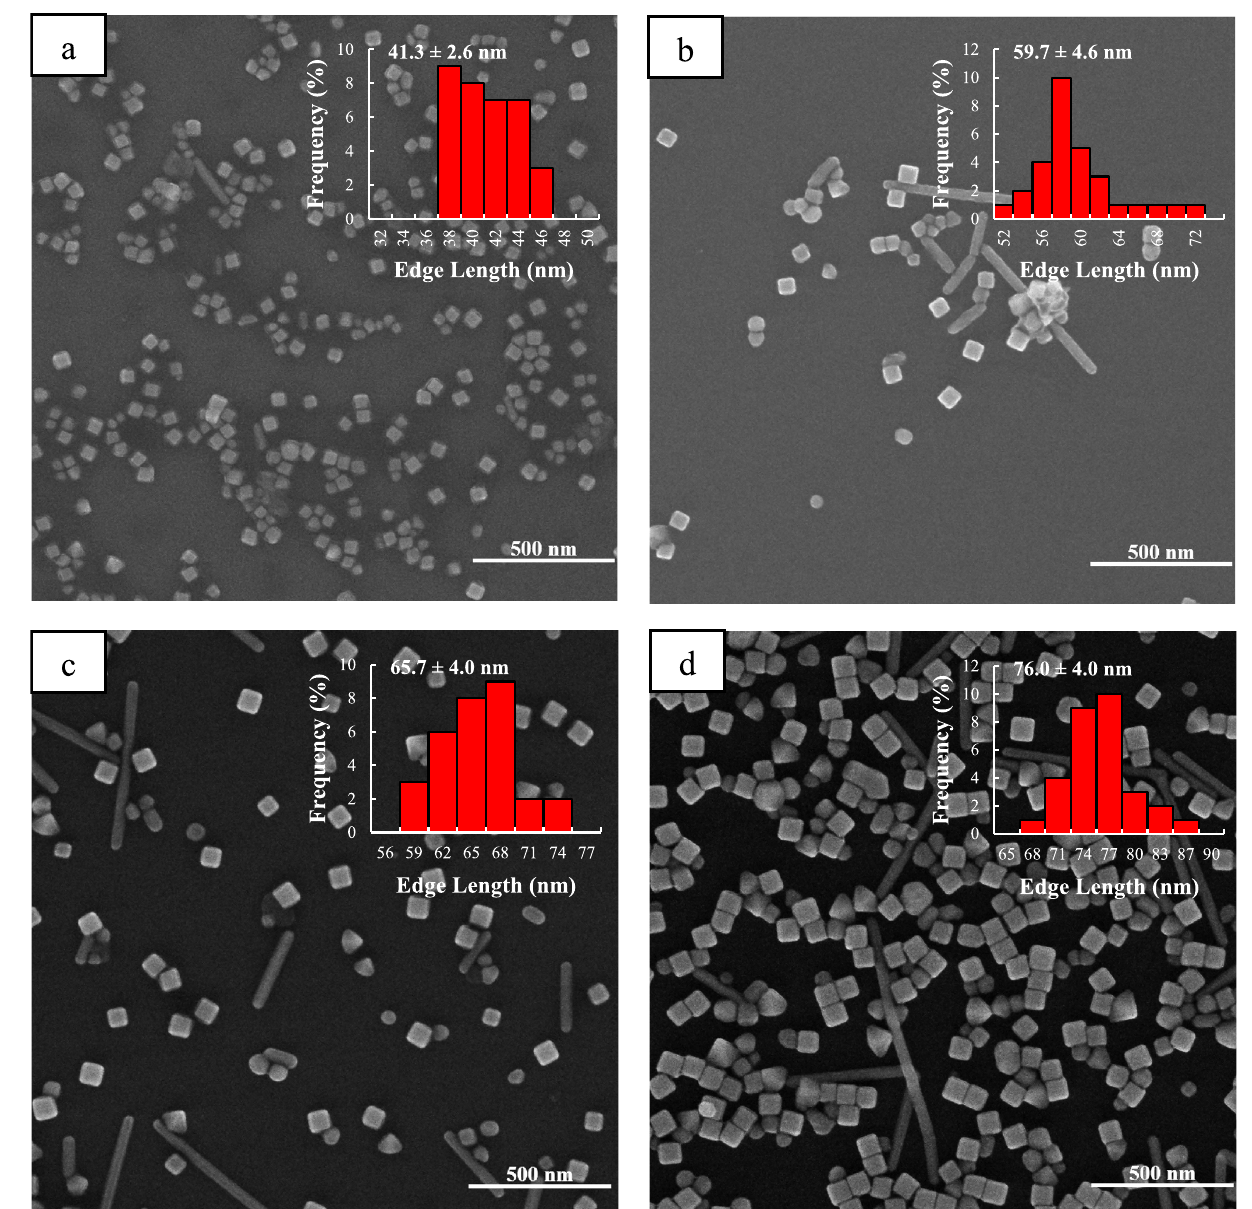
Figure 3. SEM images of Ag nanocubes obtained under irradiance with 200-W incandescent lamp at different reaction times: ( a ) 15, ( b ) 30, ( c ) 60, and ( d ) 90 min. The insets show the size distribution of the Ag